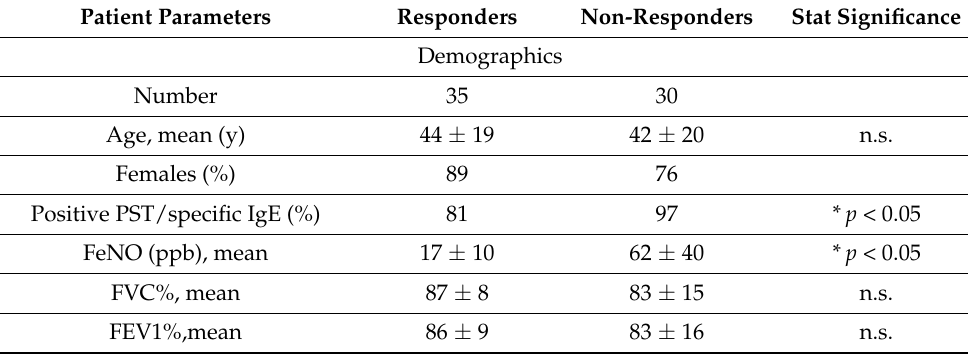
Table 1. Baseline characteristics between responders vs.